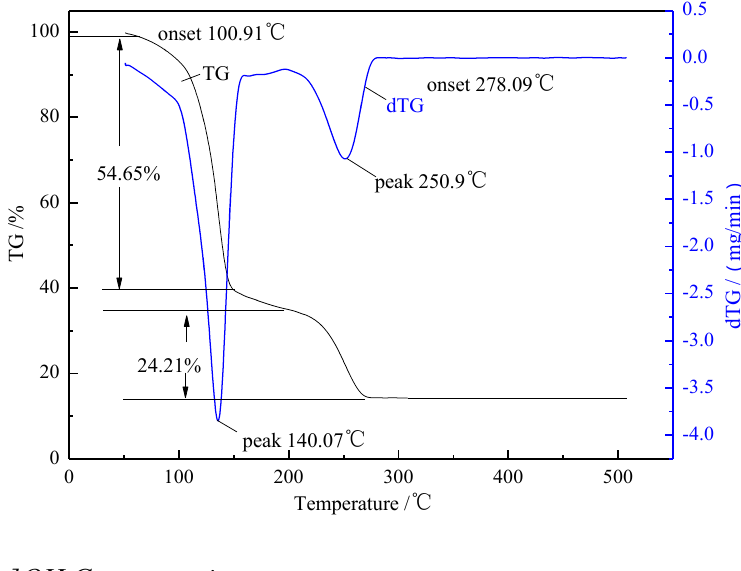
Figure 2. TG analysis of various ionic liquids